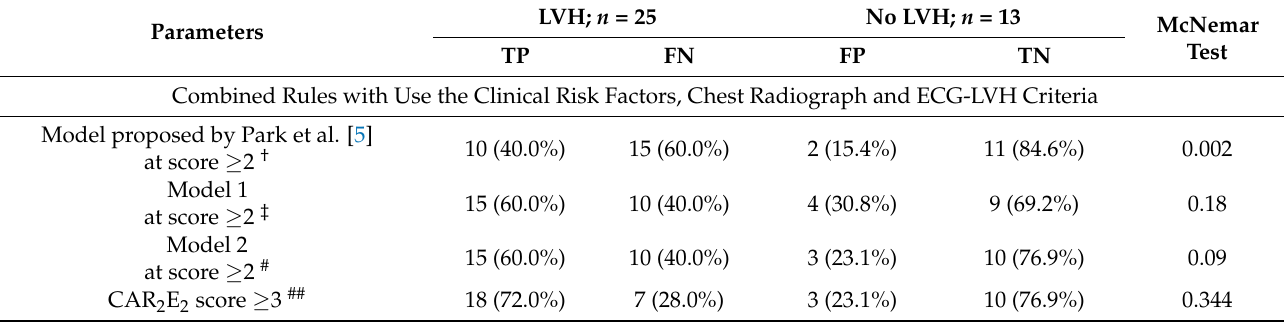
Table 5. Combined criteria in the screening of left ventricular hypertrophy in patients with and without left ventricular hypertrophy based on left ventricular mass indexed by body surface area.